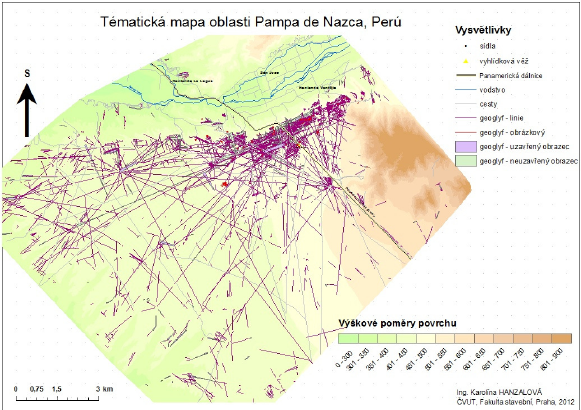
Figure 2. General view on the map of